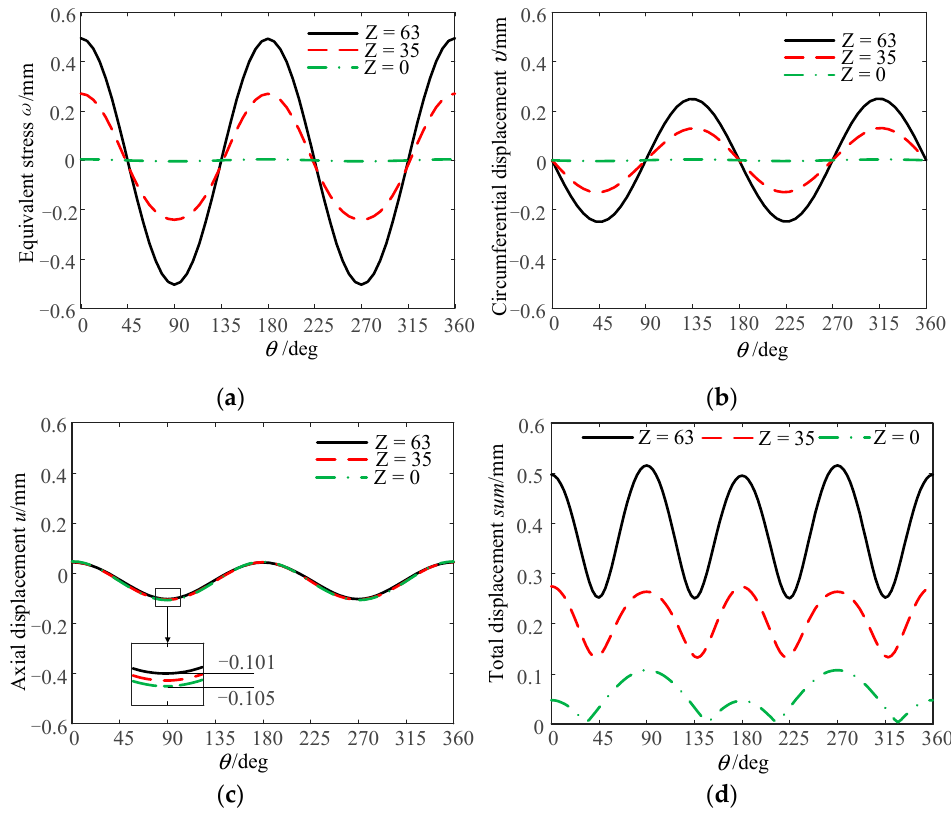
Figure 10. Deformation of the flexible wheel at different sections. ( a ) Radial displacement; ( b ) Circumferential displacement; ( c ) Axial displacement; ( d ) Total displacement.